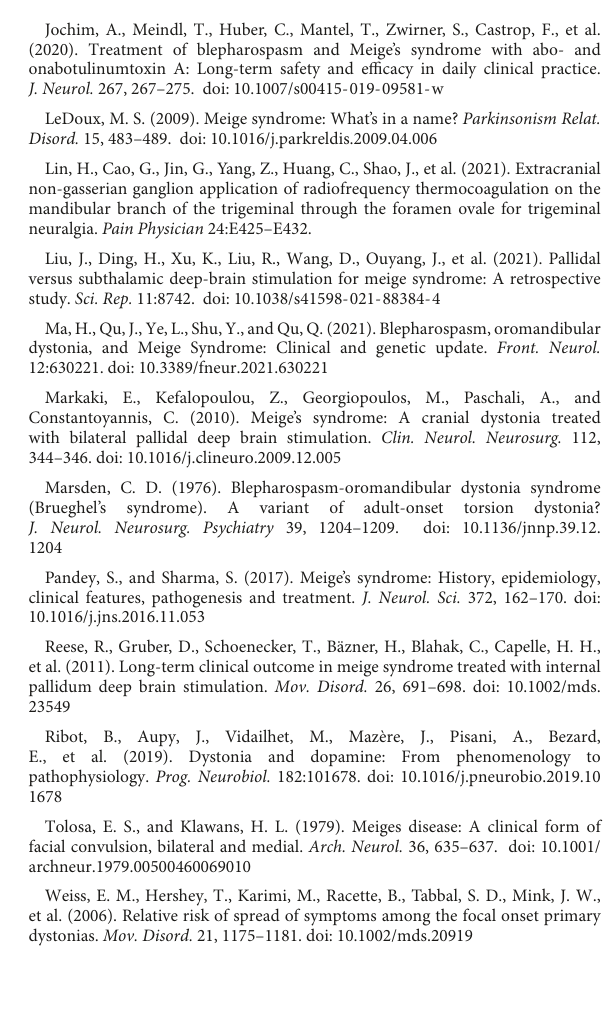
SUPPLEMENTARYVIDEO1 Facial muscles beat rhythmically with facial nerve